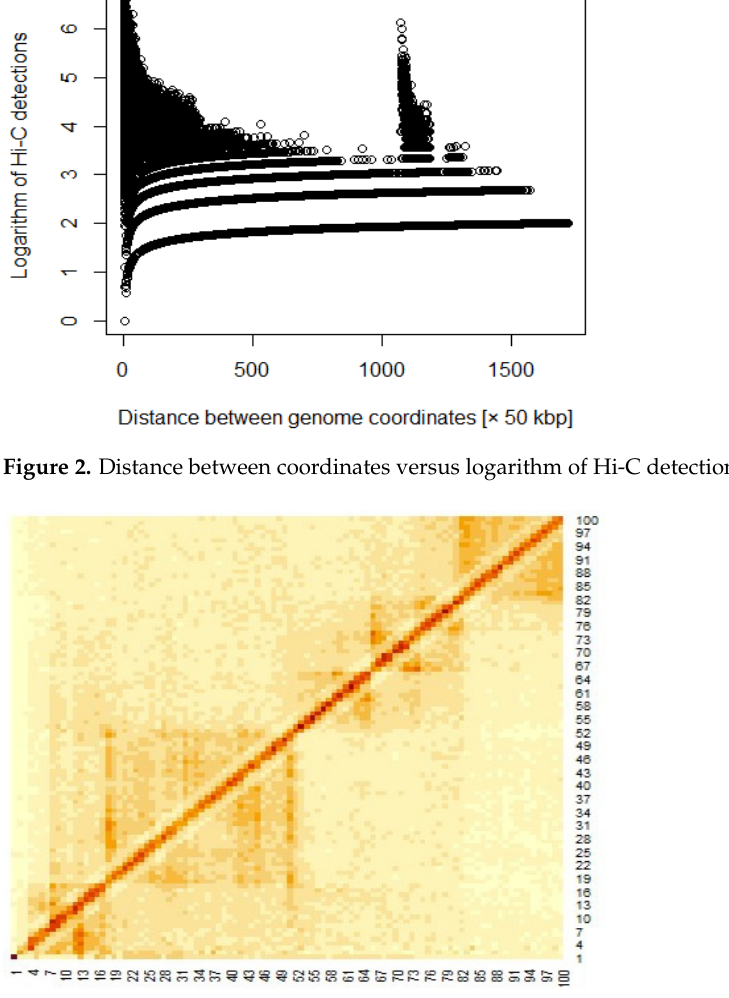
Figure 3. Heat map of Hi-C data after adding